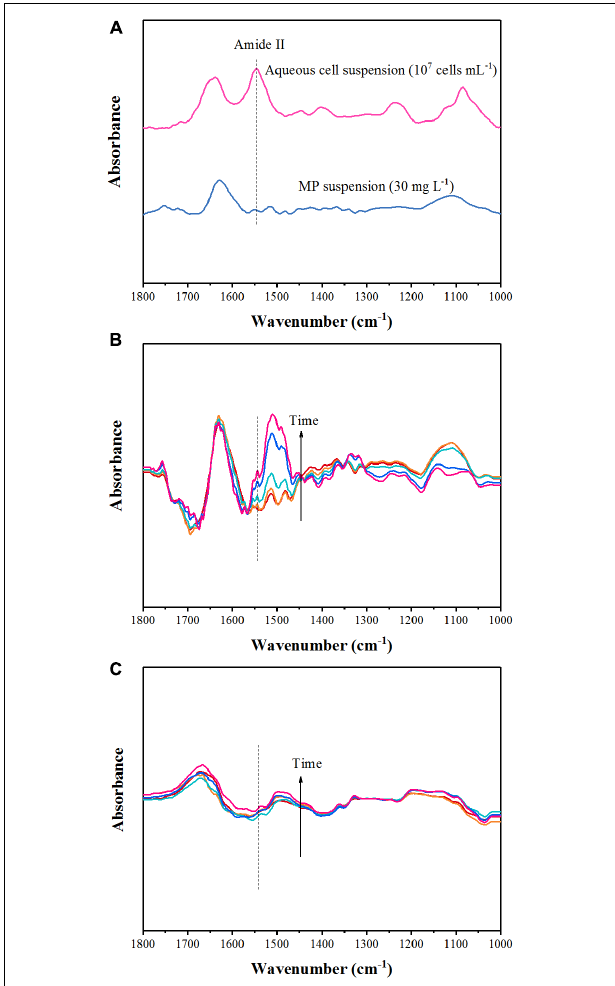
FIGURE 3 | Attenuated total reflectance-Fourier transform infrared (ATR-FTIR) spectra of aqueous Pseudomonas sp. Z1 suspension and MP solution (A) , and collected as a function of time from the biodegradation experiment of the reaction between Pseudomonas sp. Z1 and goethite (B) and HA-goethite complex (C)